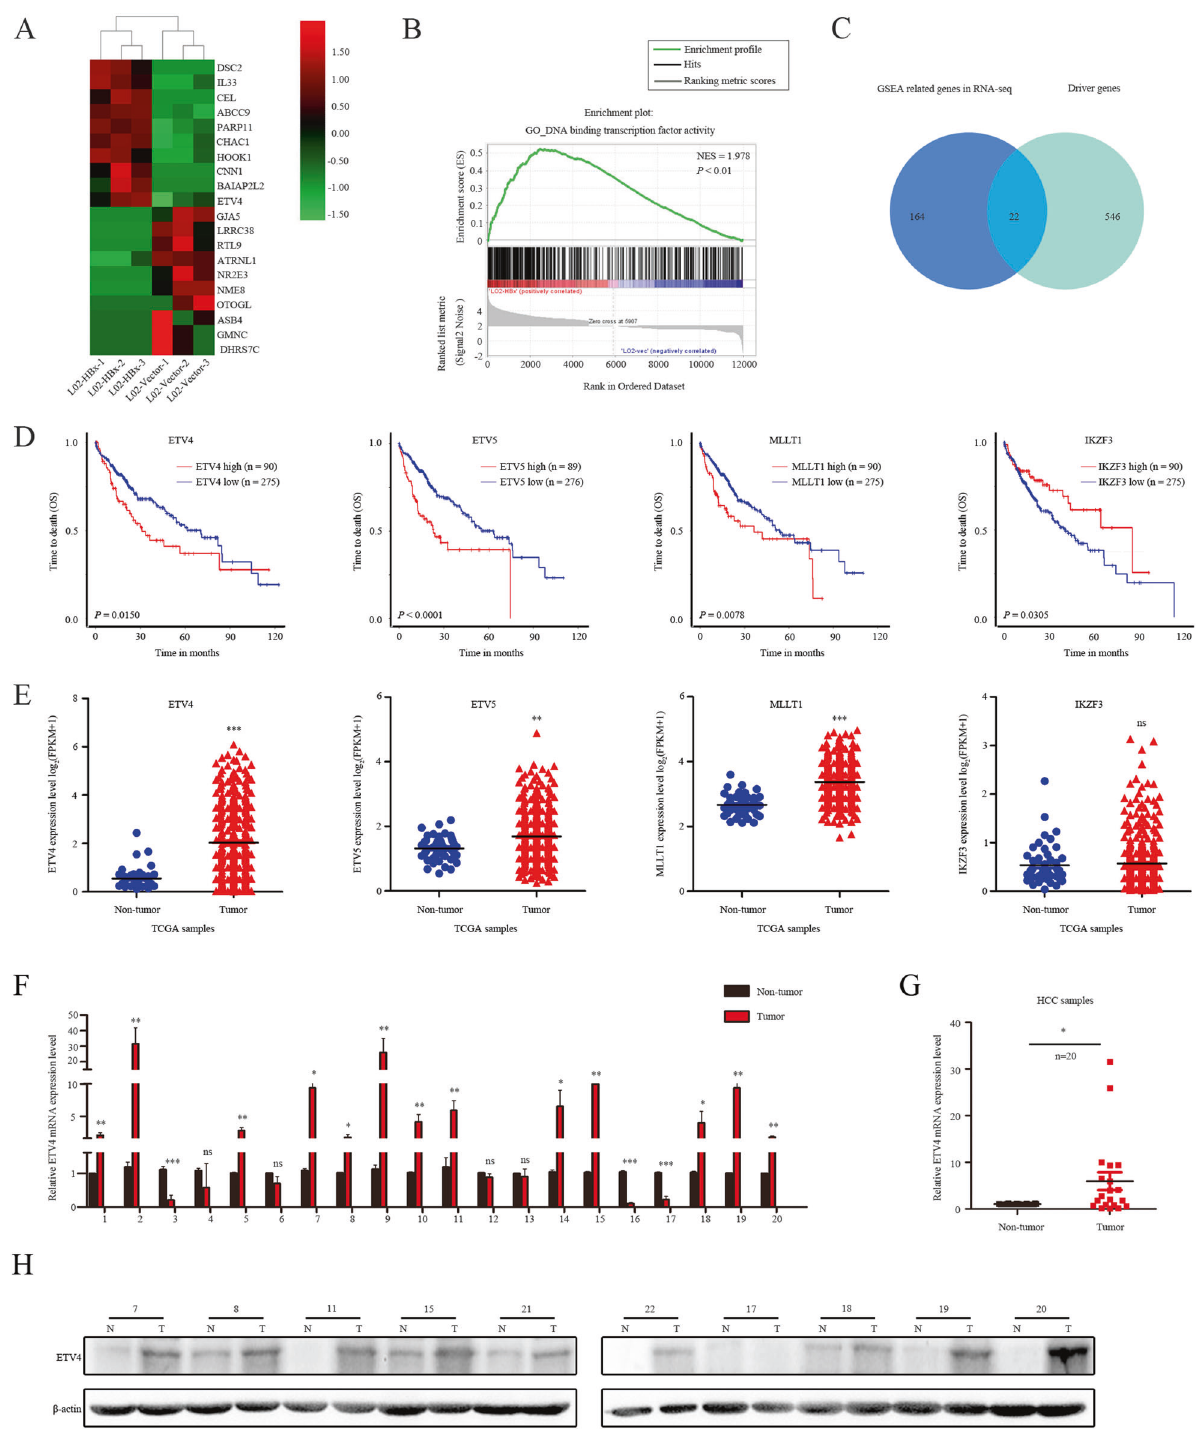
Fig. 1 Altered gene expression pro fi le in L02-HBx and L02-vector cells. A Heatmap of differentially expressed genes (DEGs) induced by HBx transfection in the RNA-seq analysis. B Gene set enrichment analysis (GSEA) comparing the gene sets of DNA binding TF activity in the HBx group. NES represents the normalized enrichment score ( P < 0.01). C Twenty-two genes were identi fi ed after intersection analysis between the DNA binding TF activity signaling pathway and 568 driver genes using Venn diagram software. D Kaplan – Meier survival curve analysis representing probabilities of overall survival (OS) in 371 HCC patients according to ETV4, ETV5, MLLT1, and IKZF3 expression. Statistical analysis was conducted using Student ’ s t -test and the log-rank test. E Four of 22 intersectional genes expression showed signi fi cant differences in 371 HCC tissues and 50 nontumor tissues from TCGA database. F The mRNA level of ETV4 was detected by qRT – PCR in 20 pairs of HCC tissues. G The statistical graph shows the mRNA expression levels of ETV4 in 20 pairs of HCC tissues. H ETV4 protein level was detected by Western blotting (WB) in ten pairs of HCC